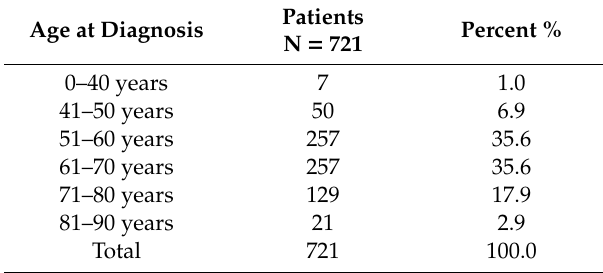
Table 1. Patient distribution by age